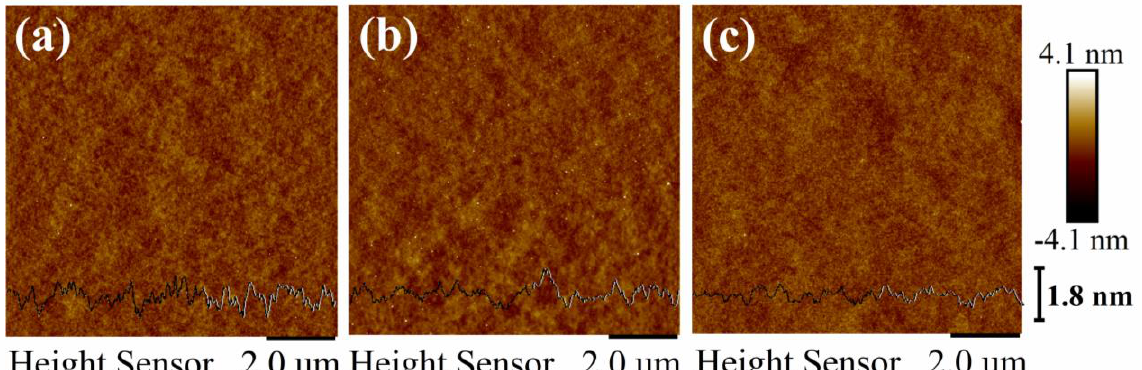
Figure 5. AFM height images and section analyses of the free (air) surface of crosslinking network ( a ) CPBCS3-1, ( b ) CPBCS5-1, and ( c ) CPBCS10-1 solids (upper data).